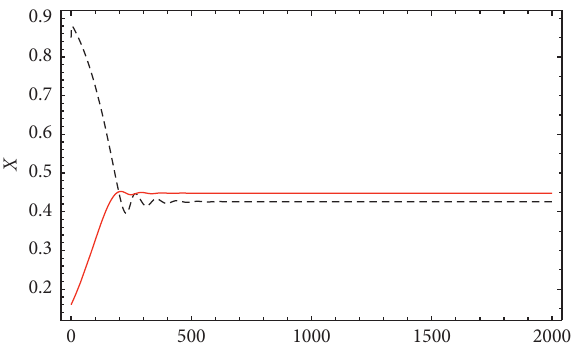
, τ ) � ( 3 , 1 ) satisfying τ 1 2 ( x ,y ) of system (32) is asymptotically stable. ∗ ∗ ∗